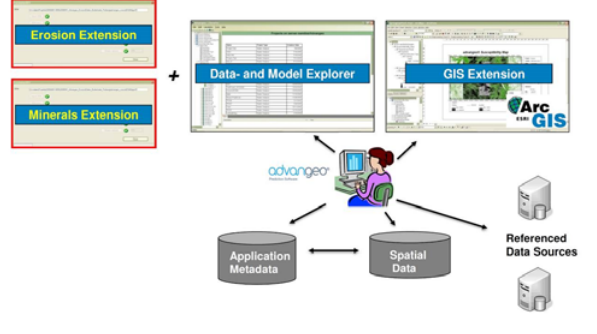
Figure 3. Architecture of advangeo®